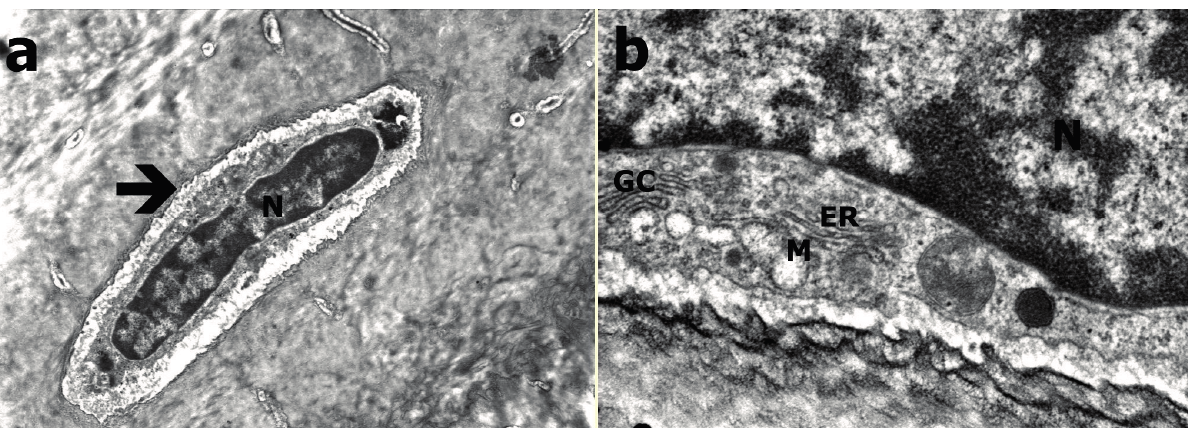
Figure 4. TEM evaluation of Group B ( a ) Osteocyte (arrow; N refers to nucleus; at 21K×); ( b ) Granular endoplasmic reticulum (ER), mitochondria (M), golgi complex (GC; at